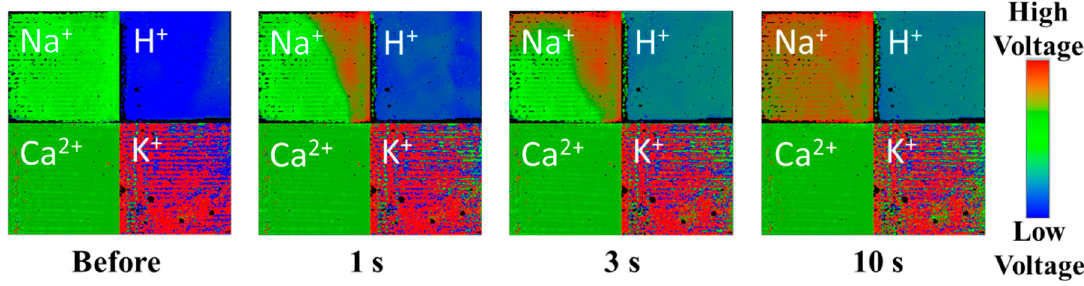
Figure 7. Visual image changes for the instant addition of a phosphate buffer solution (pH 7) to a borate buffer solution (pH 9). This sensor chip is different from the sensor chip shown in Figure 6.